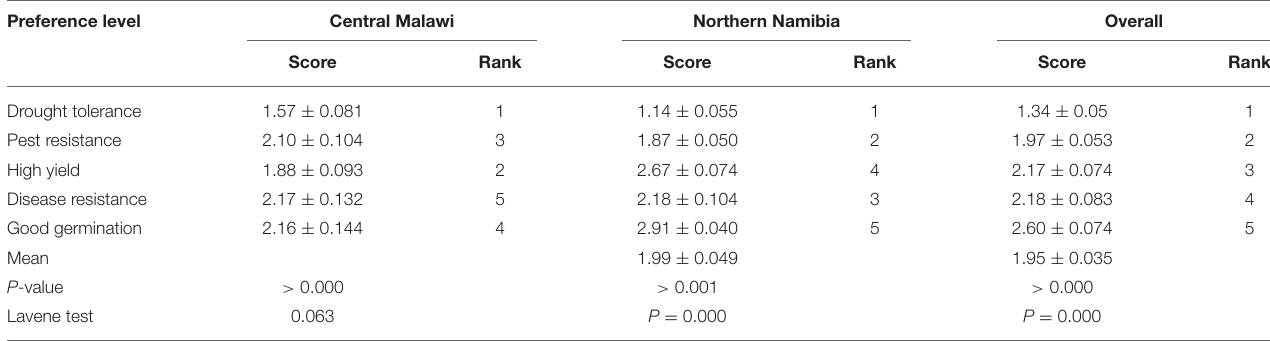
TABLE 4 | Preference of the spider plant traits across the study sites in Malawi based on three choices as the most important trait (1), second most important trait (2), and third most important trait (3). Preference level